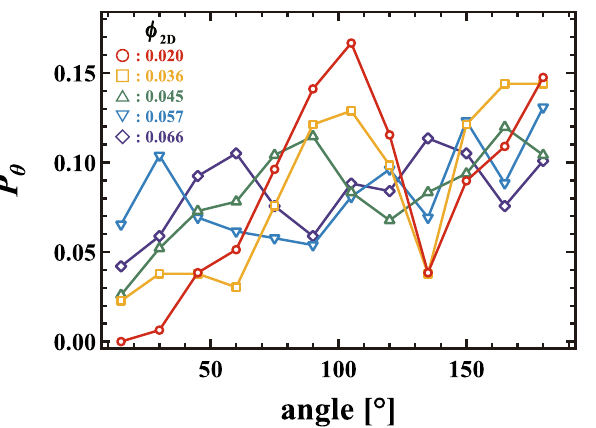
Figure 4. Probability distribution P θ of the angle between displacement vectors of bubbles in contact in the collective rearrangement events. Red circle, orange square, green triangle, light blue reversed triangle and navy blue diamond symbols correspond to average φ 2 D = 0.020, 0.036, 0.045, 0.057, and 0.066, respectively. For dry 90 180 0.045 , P foams, φ 2 D θ has peaks at θ = ◦ and ◦ . Meanwhile, for wet foams, the shape of the peak becomes ≤